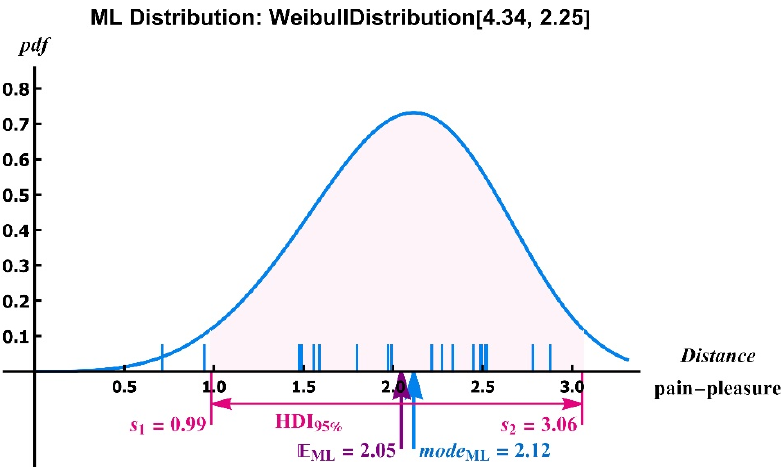
× and (cid:2871) × (cid:2870) (cid:2870)